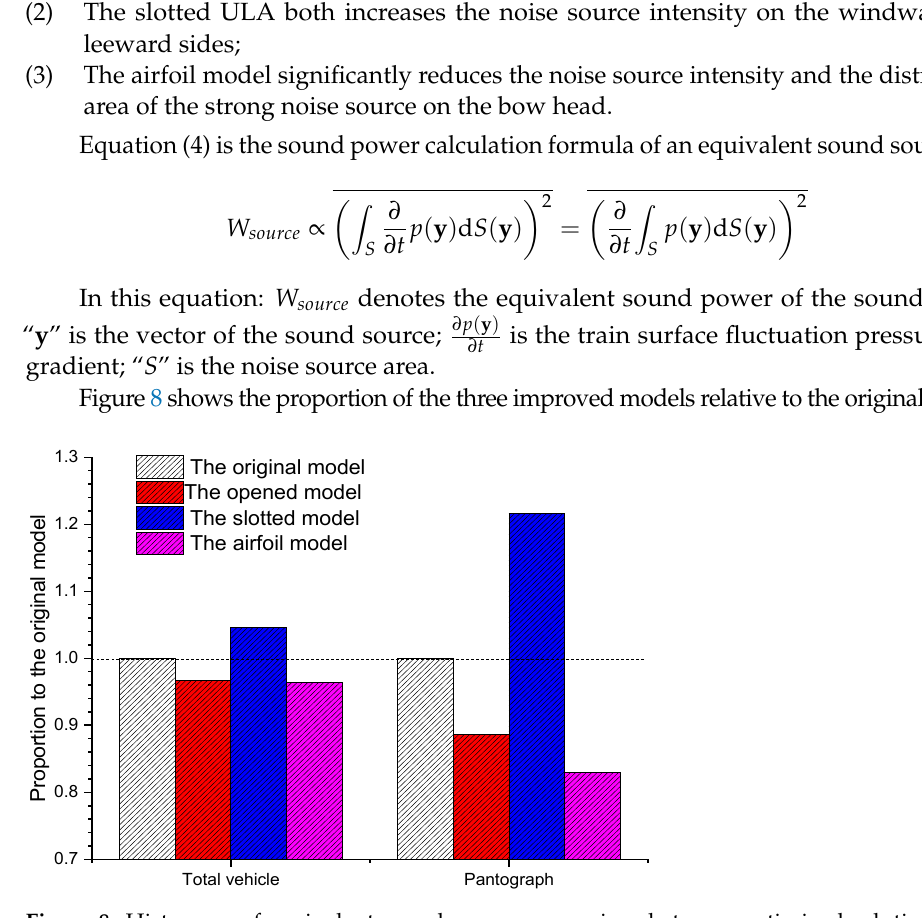
Figure 8. Histogram of equivalent sound power comparison between optimized solutions in the upper and middle parts of the pantograph.